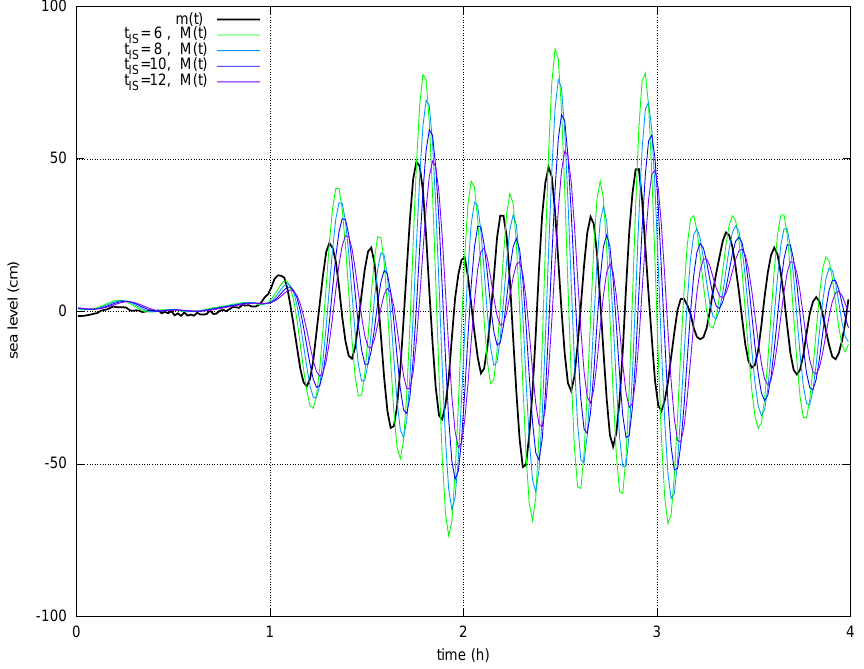
Fig. 3b. The figure shows the detided signal m(t) of the Andreanov 1996 tsunami recorded at the Adak tide gauge together with the functions M(t) of the TEDA secure detection computed for different t IS values ( t IS = 6, 8, 10, 12min) and for the same integration interval ( t SD = 8min). Detiding of m(t) is computed off line through the cubic splines fitting of the tidal signal and by further subtraction. For the selected combinations of parameters, it is seen that M(t) is delayed with respect to m(t) and amplified, with gain increasing as t IS